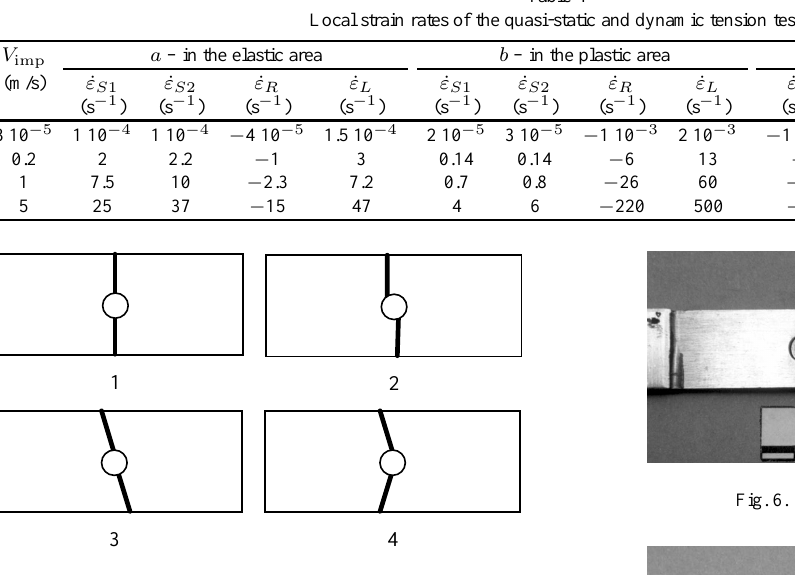
Fig. 5. Pattern schematic of punched tension specimens.